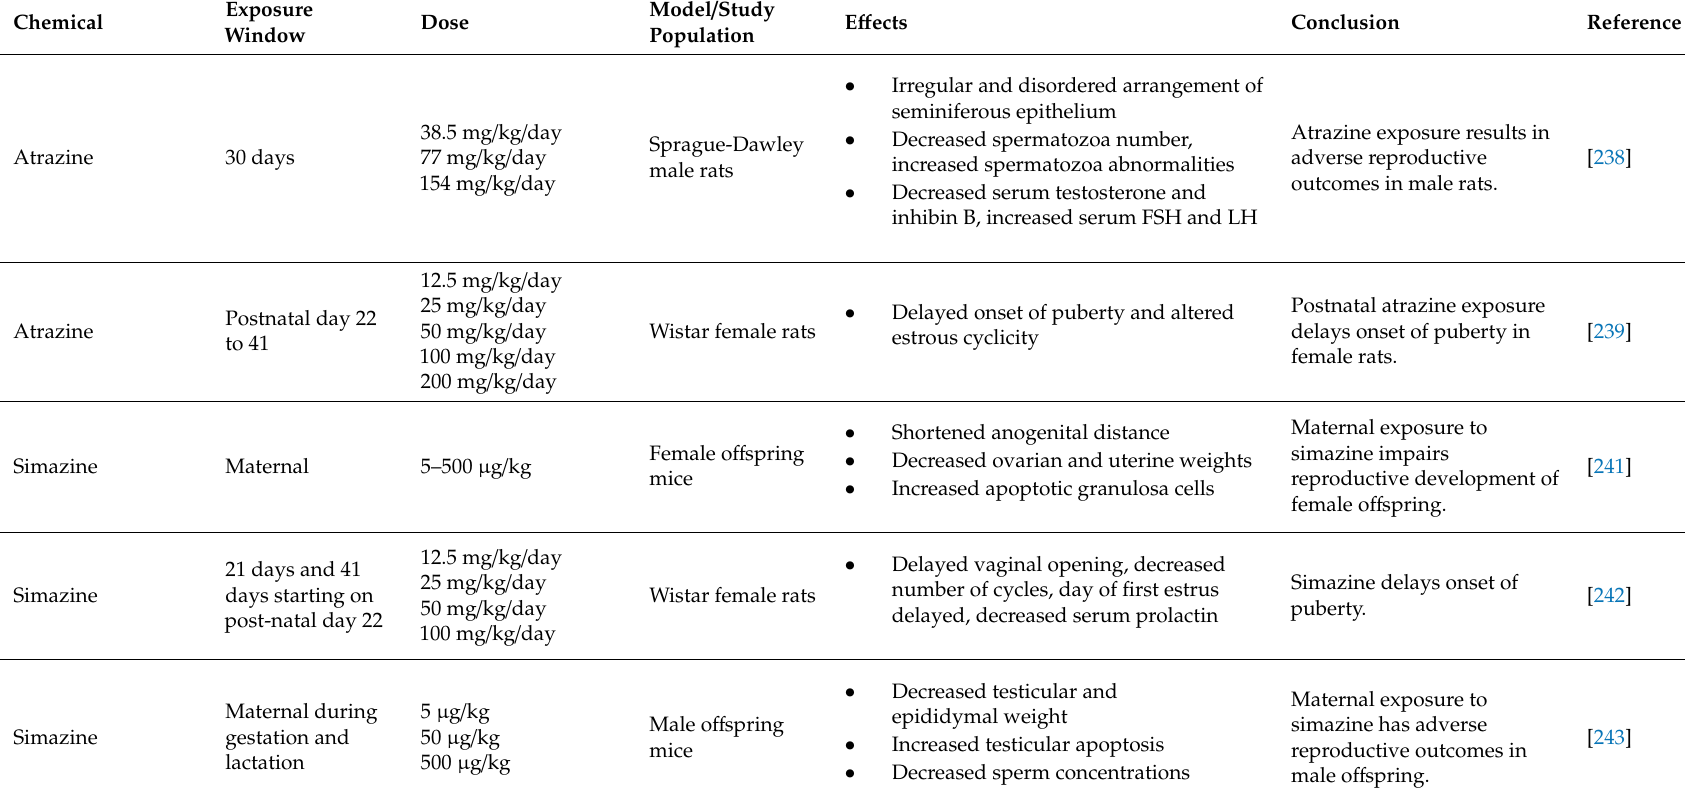
Table 7. E ff ects of Pesticides on the Reproductive